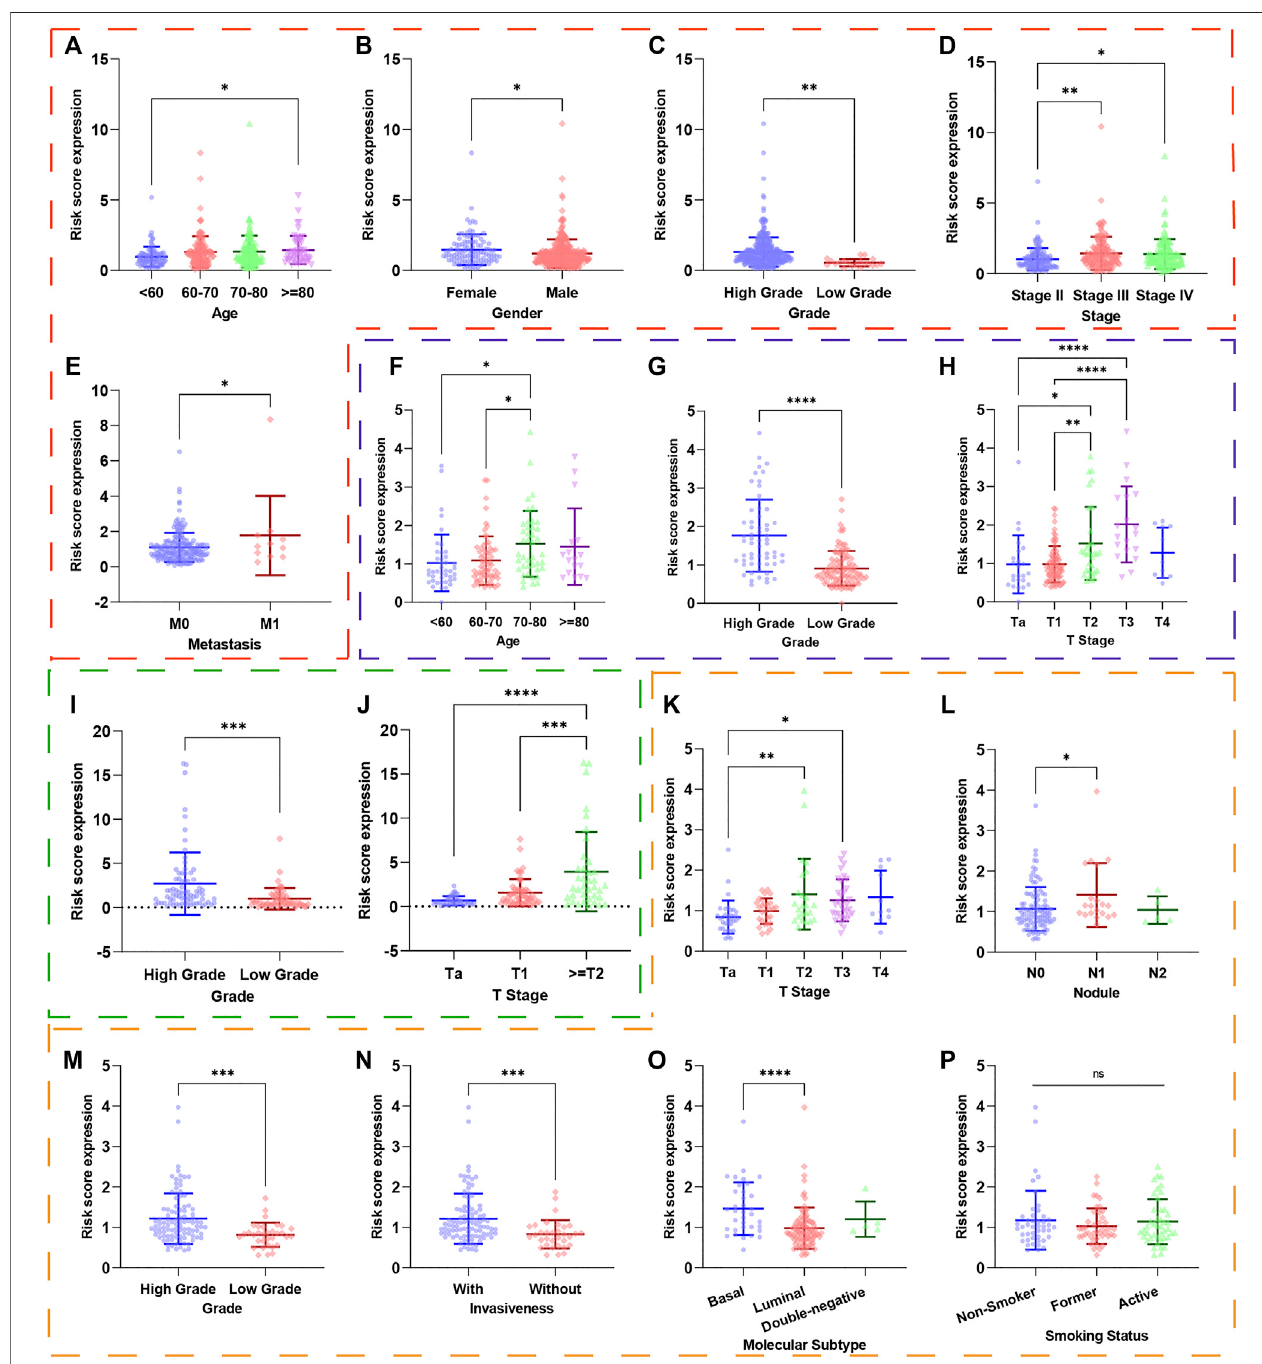
FIGURE 4 | The risk scores of patients in different subgroups were strati fi ed by clinicopathological parameters. The red, blue, green, and orange dashed boxes corresponded to the subgroupsin the TCGA, GSE13507, GSE32548, and GSE48075, respectively. The risk scores were signi fi cantly different in subgroups of (A) age, (B) gender, (C) pathological grade, (D) AJCC-stage, and (E) metastasis in the TCGA dataset. Similarly, the risk scores were still different in subgroups of (F) age, (G) pathological grade, and (H) T-stage in GSE13507; in subgroups of (I) pathological grade and (J) T-stage in GSE32548; in subgroups (K) T-stage, (L) nodule, (M) pathological grade, (N) invasiveness, (O) molecular subtypes in GSE48075. Interestingly, the risk score did not correlate with smoking ( p ). * p < 0.05; ** p < 0.01; *** p < 0.001; **** p < 0.0001; ns: not signi fi cance signi fi cant.